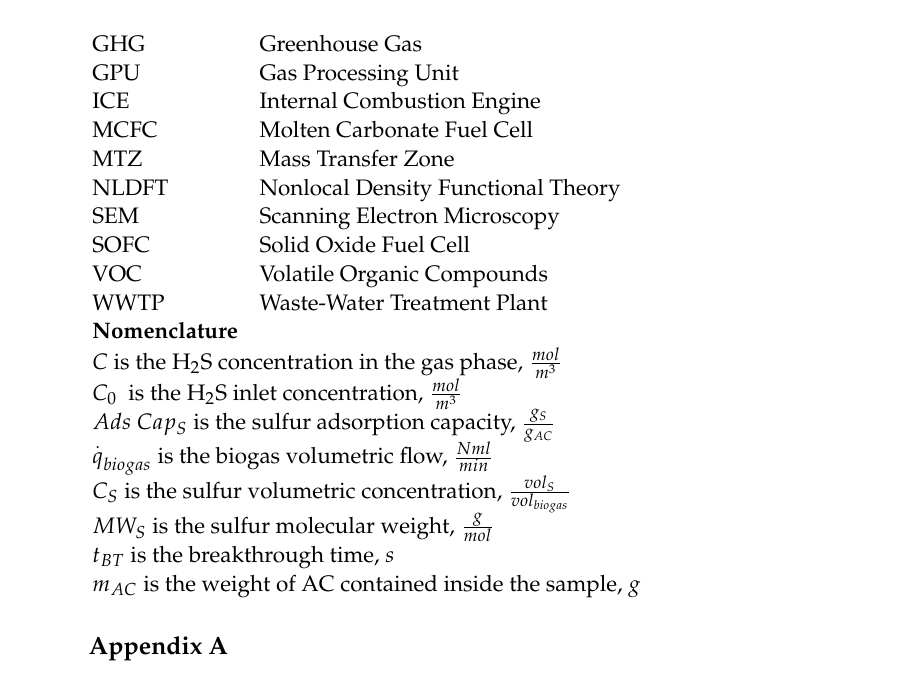
Table A1. EDS analysis results of the samples. The atomic concentration is a percentage, the remaining percentage of each sample is composed by